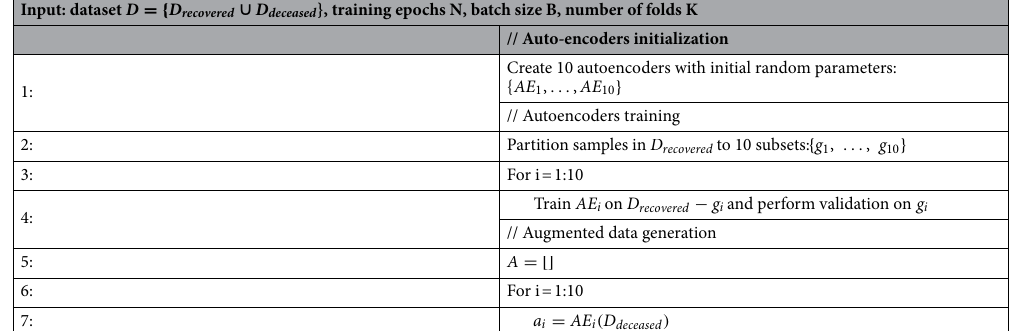
Algorithm 1. CNN-AE pseudo-code